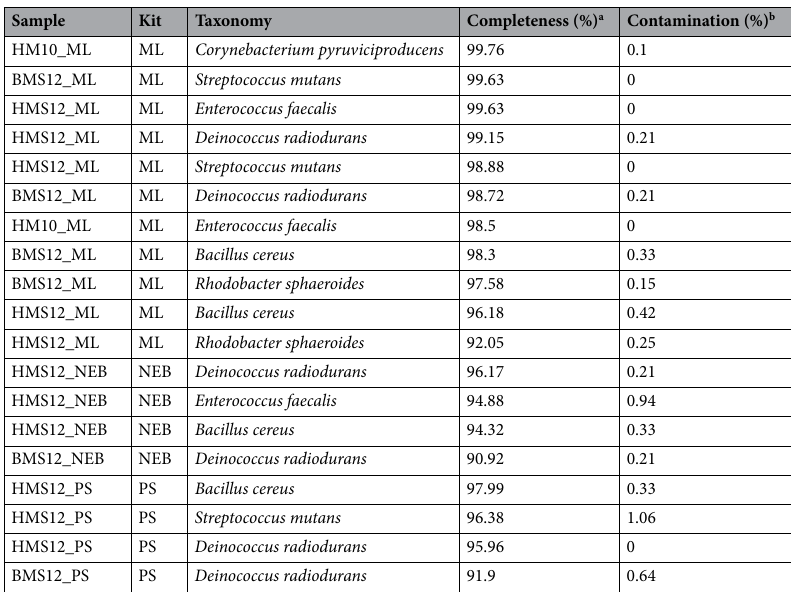
Table 1. High quality metagenome-assembled genomes from shotgun sequencing analysis. a Completeness: ratio of observed single-copy marker genes to total single-copy marker genes in the chosen marker gene set 46 . b Contamination: ratio of observed single-copy marker genes in ≥ 2 copies to total single-copy marker genes in the chosen marker gene set 46